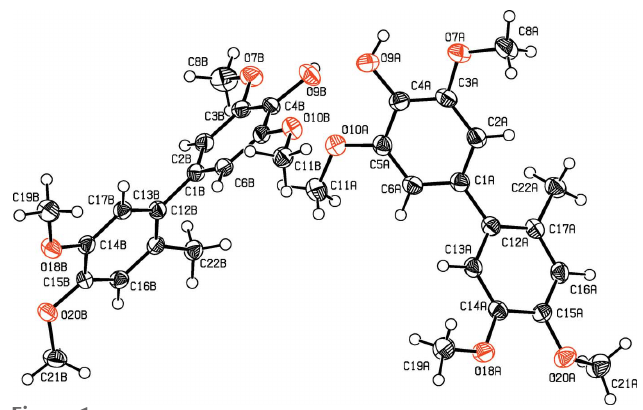
Figure 1 The molecular structure of the title compound with displacement ellipsoids drawn at the 50% probability